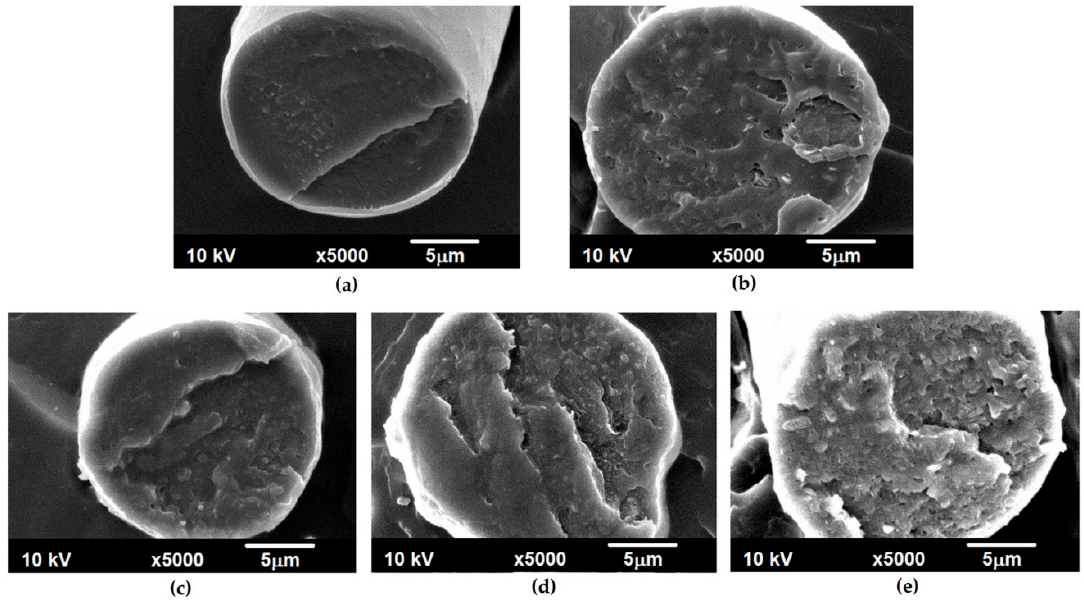
Figure 2. SEM images of the cross-sections of PBT fibers with different amounts of reduced graphene oxide: ( a ) 0 wt %; ( b ) 0.5 wt %; ( c ) 1 wt %; ( d ) 1.5 wt %; ( e ) 2 wt % (V take-up = 600 m/min).